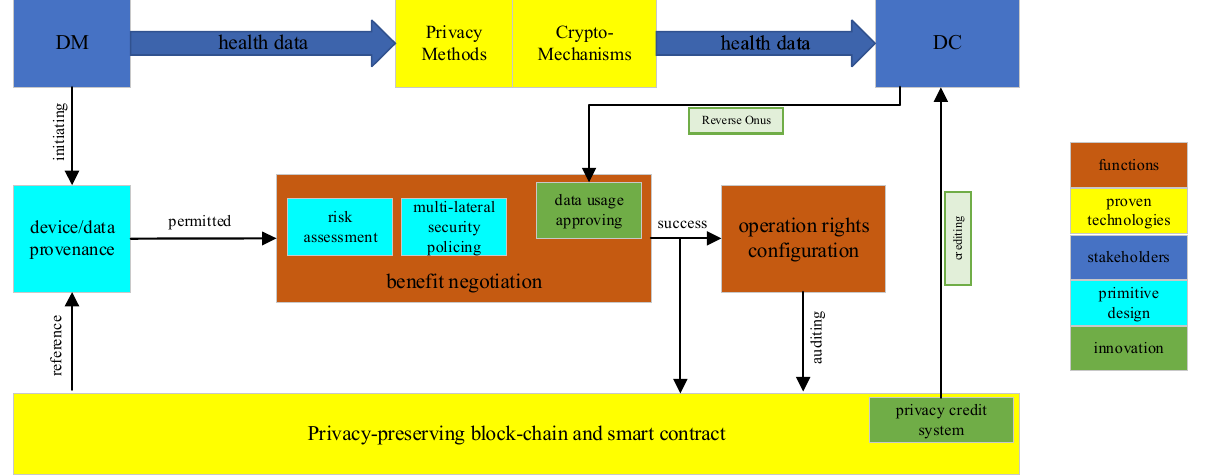
Figure 2. Function-level relational architecture.